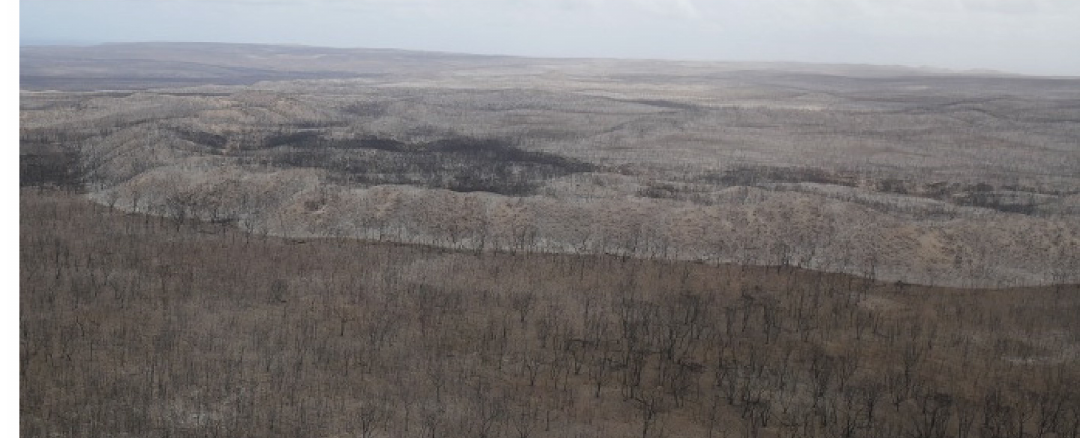
Figure 8. Oblique aerial photograph (taken 16 January 2020) showing clear boundary in soil groups between the brighter Holocene sands and the darker brown Pleistocene lowlands in the foreground. This boundary corresponds to lower fire severity in both NBR-derived fire indices with dDI giving a more uniform estimation of very high severity in these regions with a fully consumed canopy.